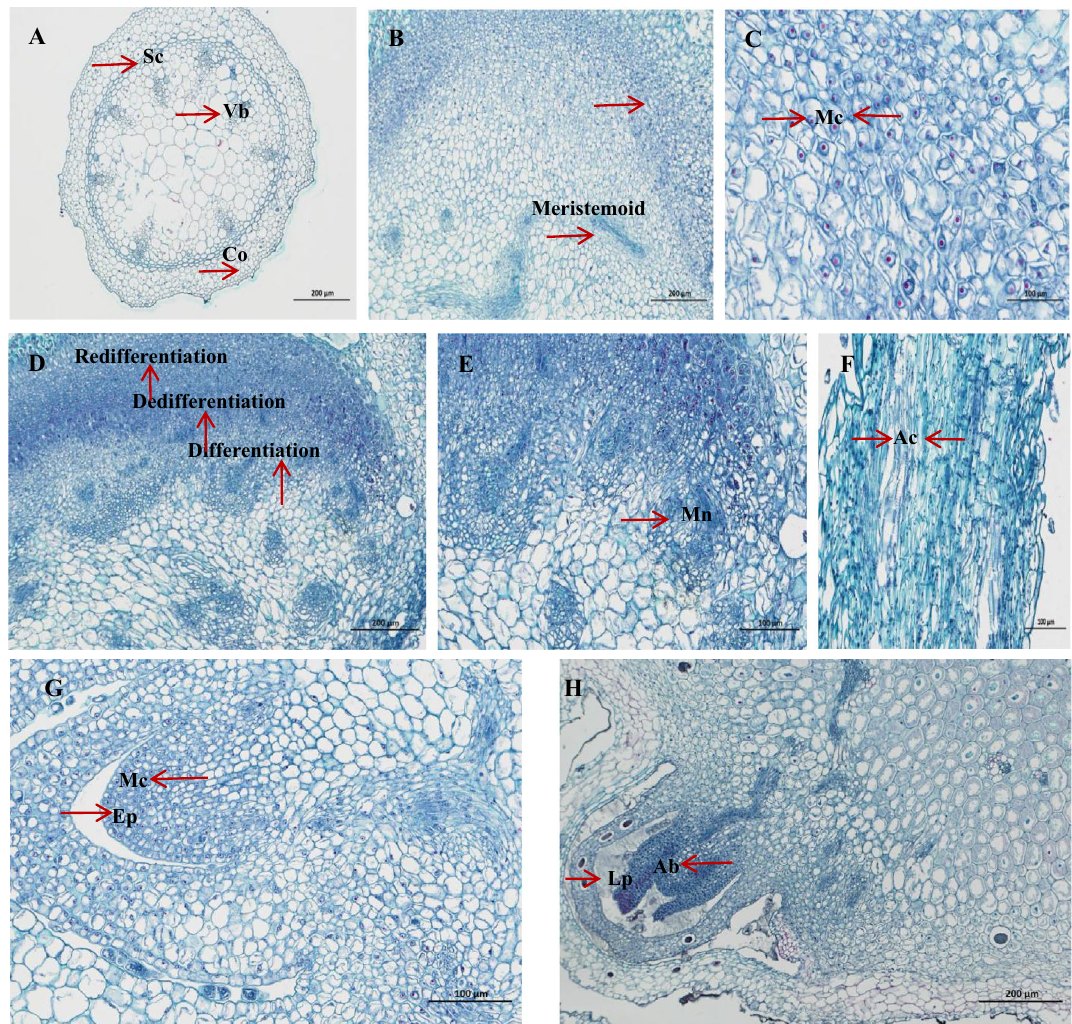
Figure 6. Histological analysis of the adventitious bud of D. nipponica. ( A ) Caulicle structure of aseptic seedling. ( B ) Dedifferentiation of cortical parenchyma cells. ( C ) Meristematic cells in callus. ( D ) Meristematic nodule in callus. ( E ) Globular meristematic masses. ( F ) Vascular tissue in callus. ( G ) Formation of bud primordia at the near-surface of callus. ( H ) Fully developed shoot bud with bud primordium and leaf primordium, arrow. (Mn-Meristematic nodule; Ac-Annular catheter; Mc-Meristematic cell; Ep-Epidermis; Lp-Leaf primordium; Ab-Adventitious bud.).